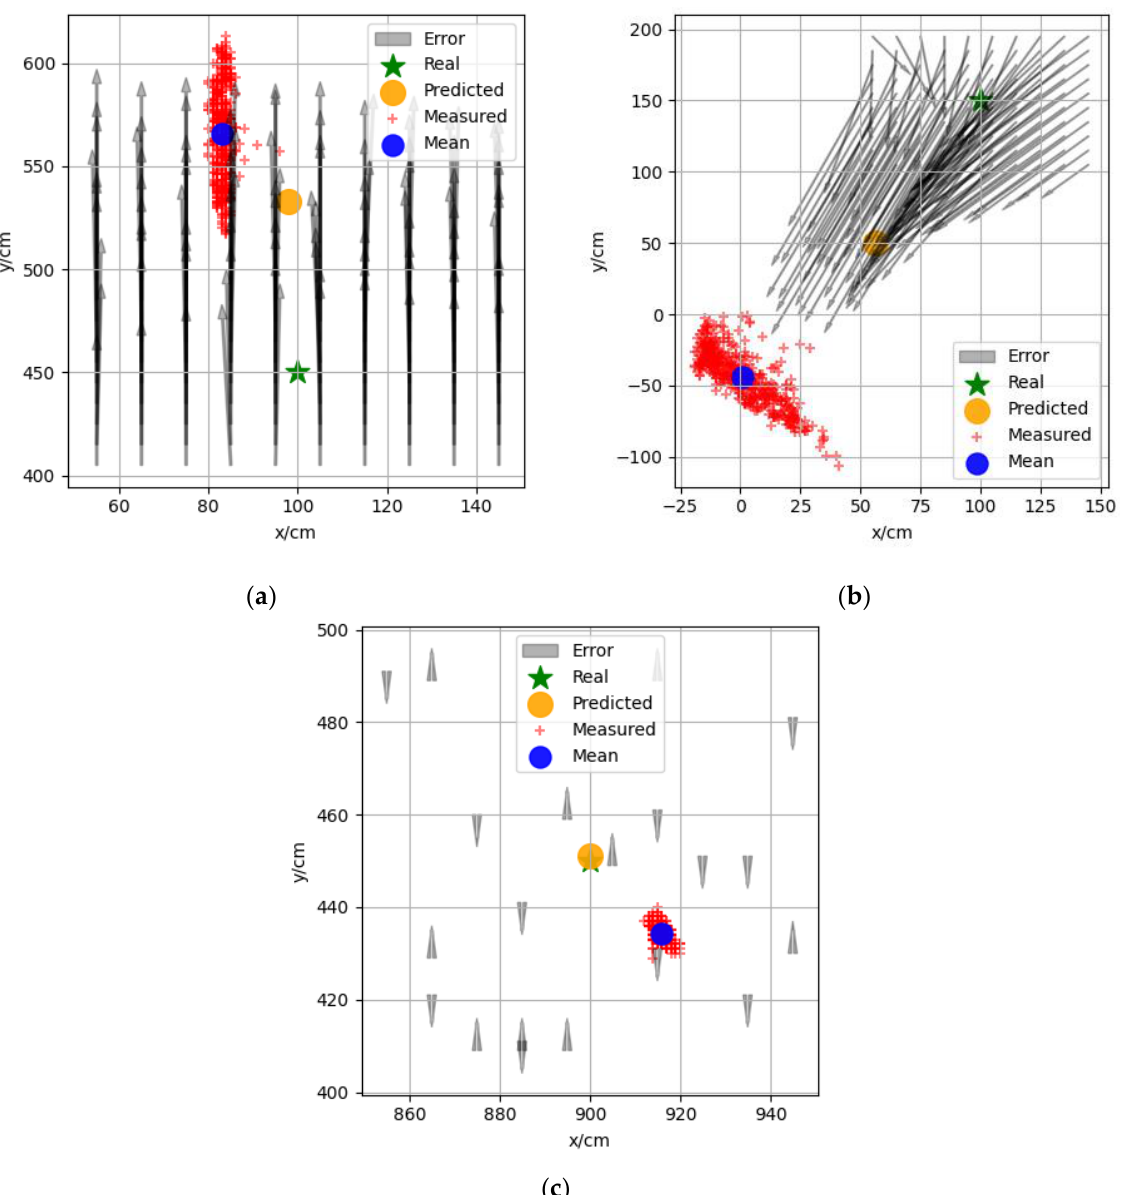
Figure 5. Real coordinates, measurement coordinates, and prediction coordinates of measuring points. Real coordinates of the measuring points: ( a ) (100,450); ( b ) (100,150); ( c ) (900,450).